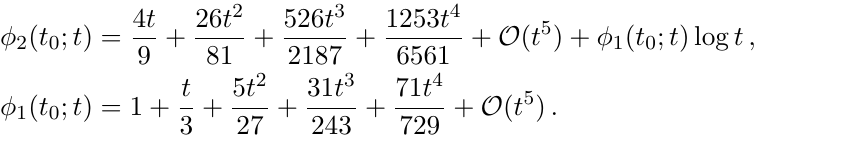
Figure 2 . Geometry associated to the sunrise differential operator L sun functions have poles at ( t ) = (0 , 1 , 9 , ∞ ) . The corresponding radii of convergence are shaded 0 , . . . , t 3 in